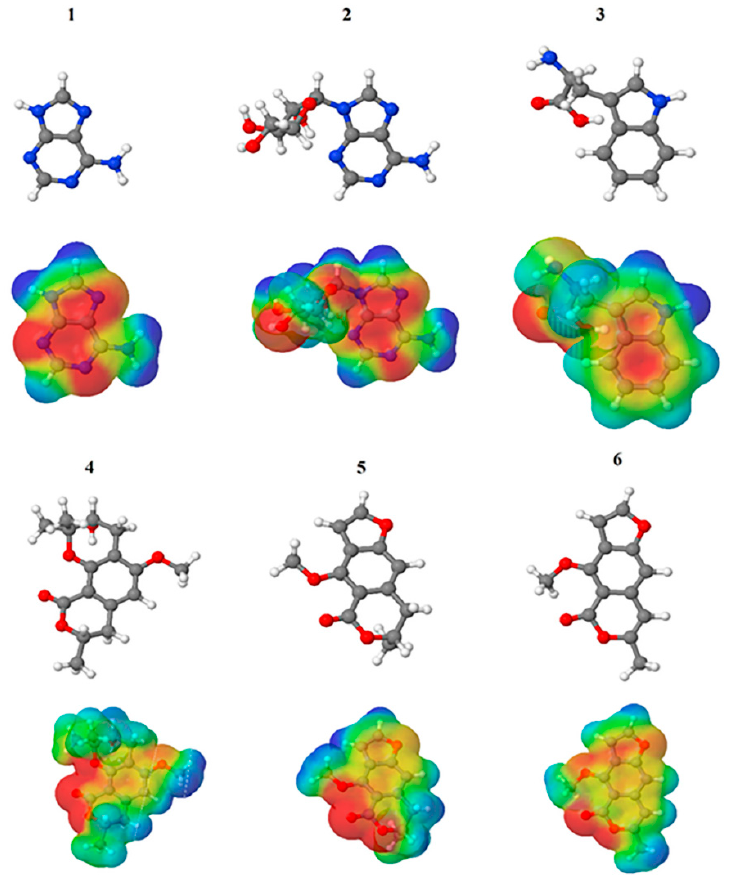
Figure 3. Electrostatic potential maps calculated onto the Connolly surfaces in the range of − 0.1 to 0.1 obtained for compounds 1 – 6 .